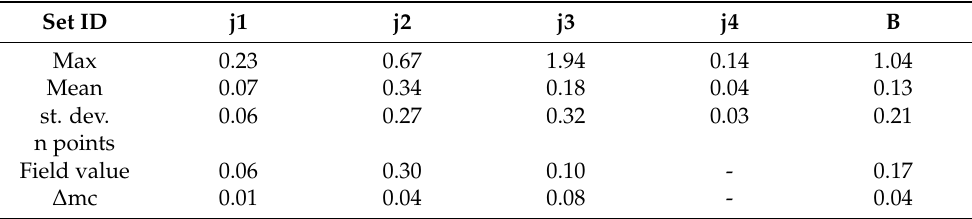
Table 3. Descriptive statistics of the calculated spacing values (expressed in meters) for each disconti- nuity